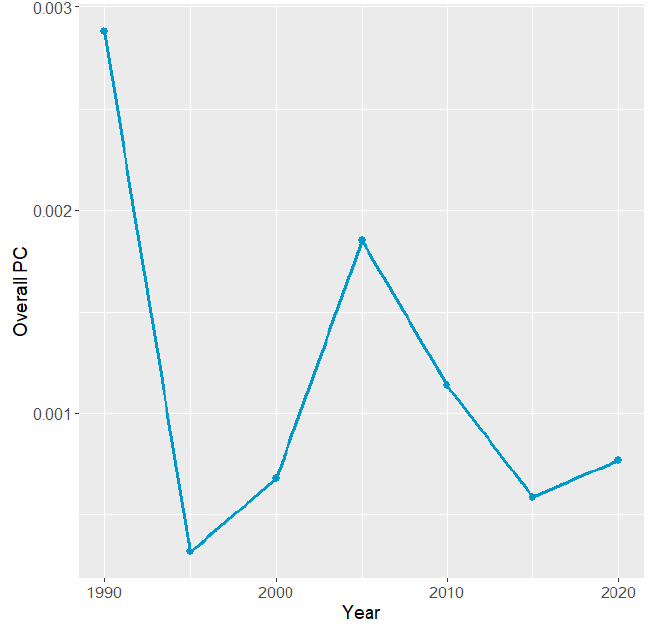
Figure 6. Overall connectivity of urban waterbodies from 1990 to 2020, as measured by the PC index.